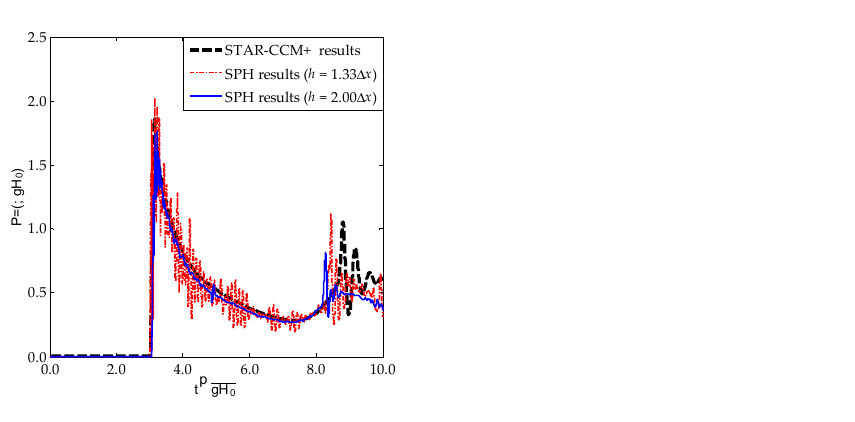
Figure 16. Comparison of the dimensionless impact pressure value at the pressure sensor ( ∆ x = 0.025 m ) .